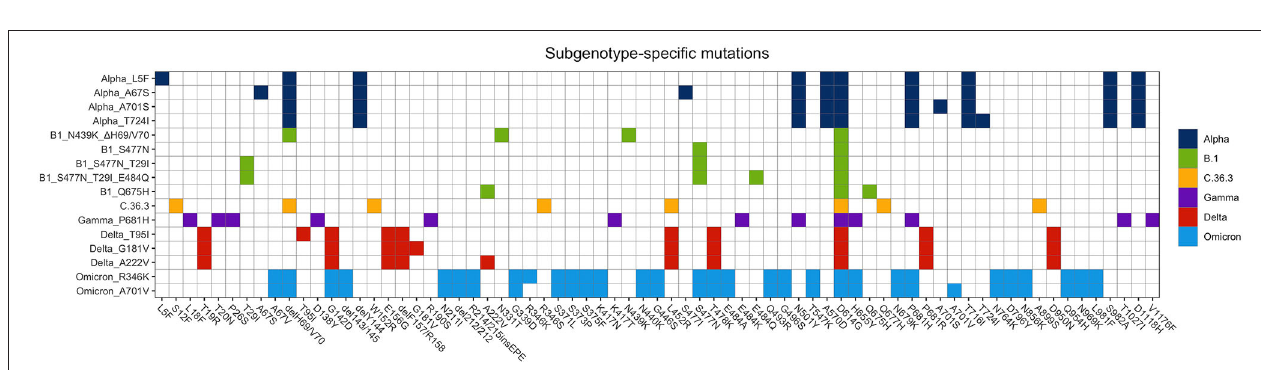
FIGURE 7 | Distribution of mutations identified in the different variants’ sub-genotypes. The chart reports the mutations that characterize the different variants’ sub-genotypes identified in this study.